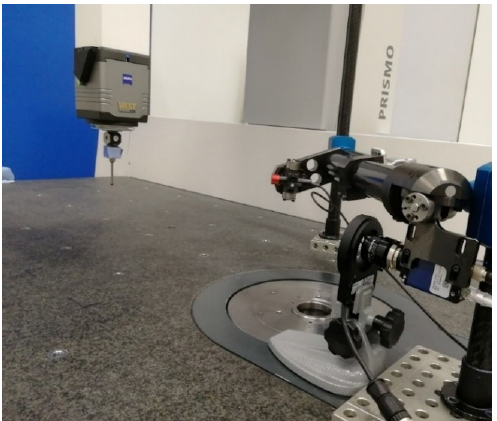
Table 2. Summary of experiments.